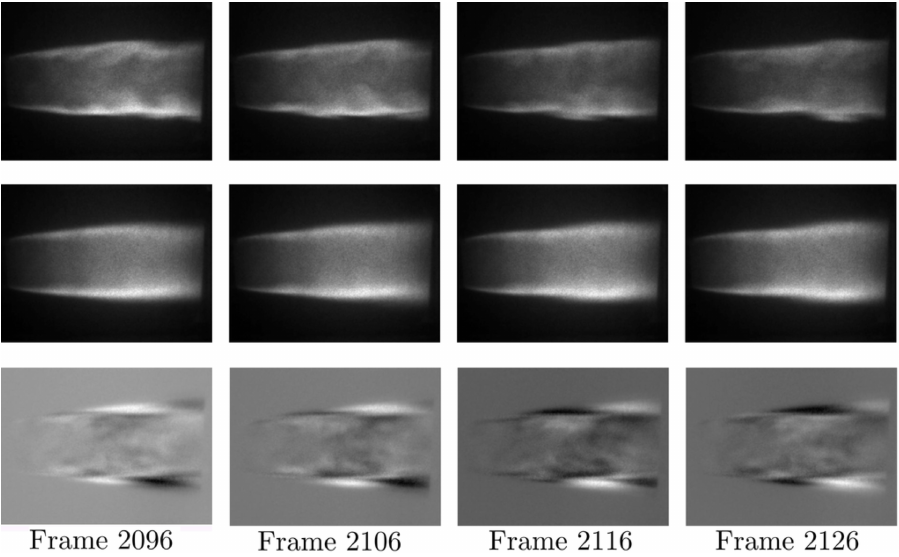
Figure 6. Several snapshots of the reacting flow at equivalence ratio φ = 0.8 ( top row ), reconstructions of the symmetric ( second row ), and asymmetric ( bottom row ) flow constituents. This figure was adapted from the Ref.